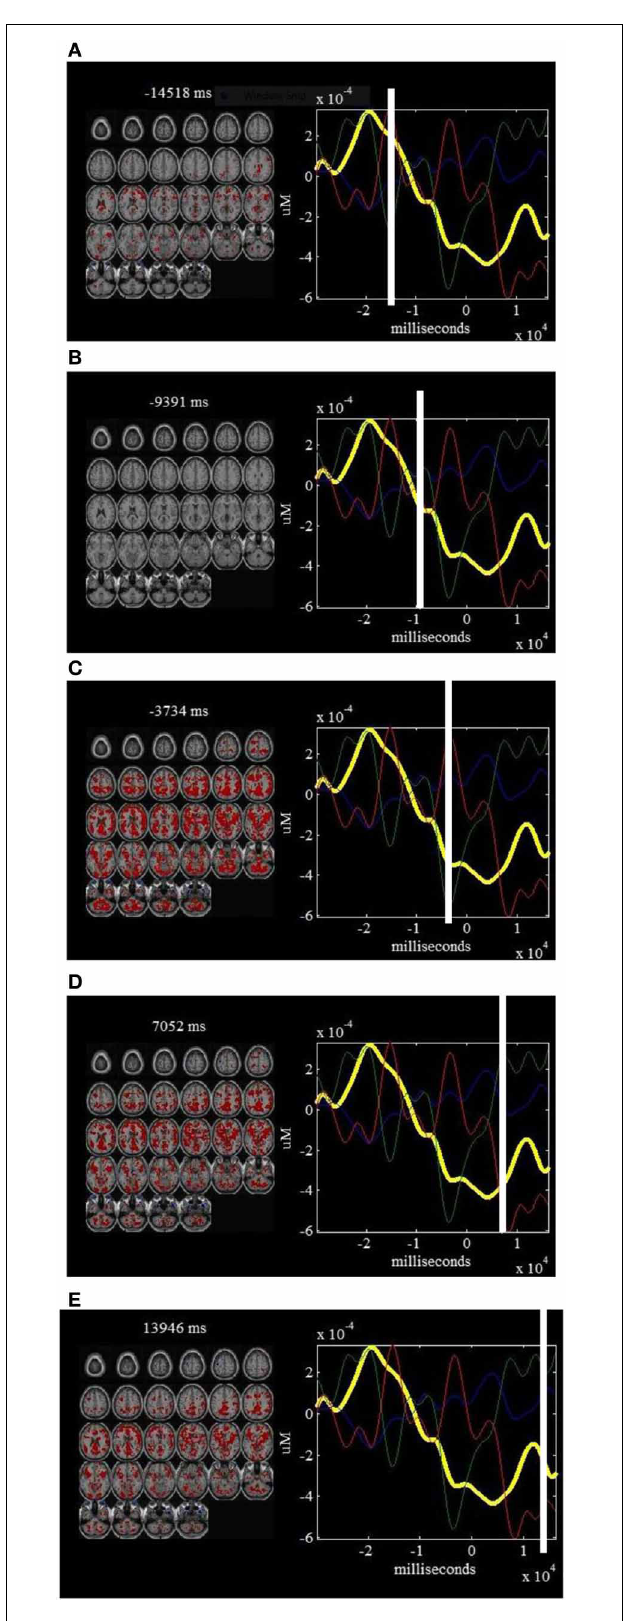
FIGURE 7 | (cid:2) HbR components and fMRI “snapshots”: on the left of each window is shown a linear combination of the fMRI maps that are well-correlated with physiology and body movement noise (composite ICs 2, 4, and 5), weighted by the (cid:2) HbR part of the components at a specific point in time. On the right of each window is shown the estimated (cid:2) HbR components that are correlated physiology and body movement noise. The time courses for IC2 (in blue), IC4 (in green) and IC5 (in red) are also plotted on the right of each window. Such a display provides a dynamic way to visualize how the noise affects the brain activity at different time points: − 14518 ms (A) , − 9391ms (B) , − 3734ms (C) , 7052ms (D) and 13946ms (E)